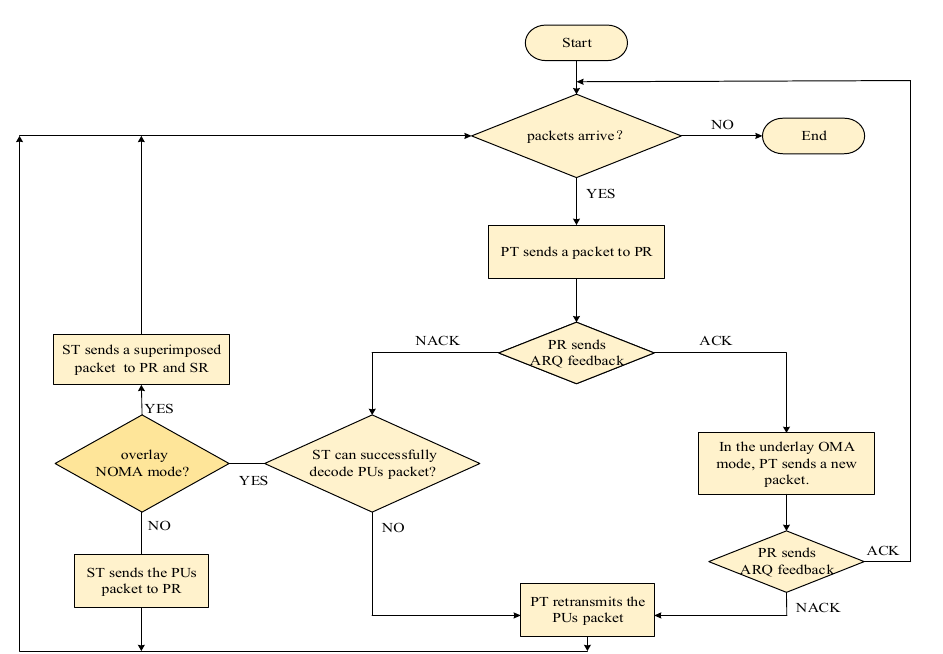
Figure 2. The flow chart of cooperative cognitive radio network based on OMA/NOMA.